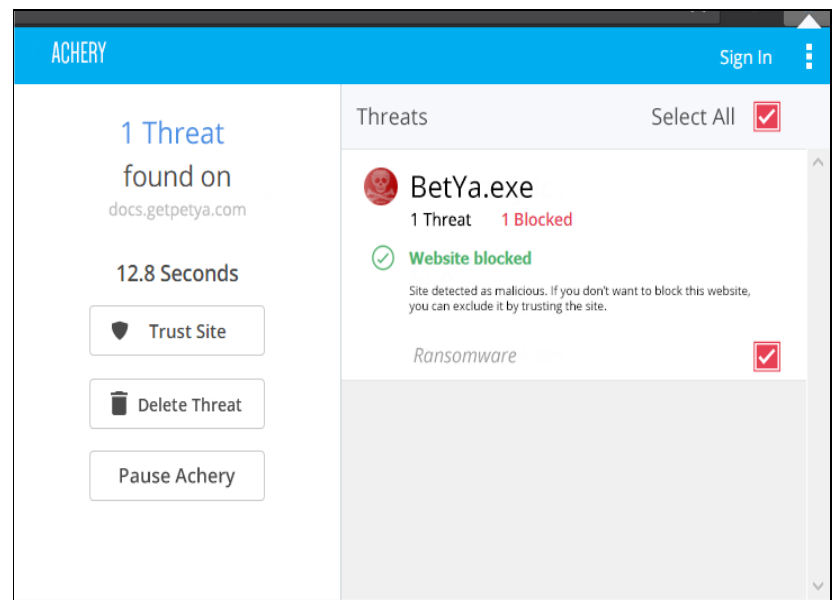
Fig. 2. Browser Extension Mockup (While Browsing)